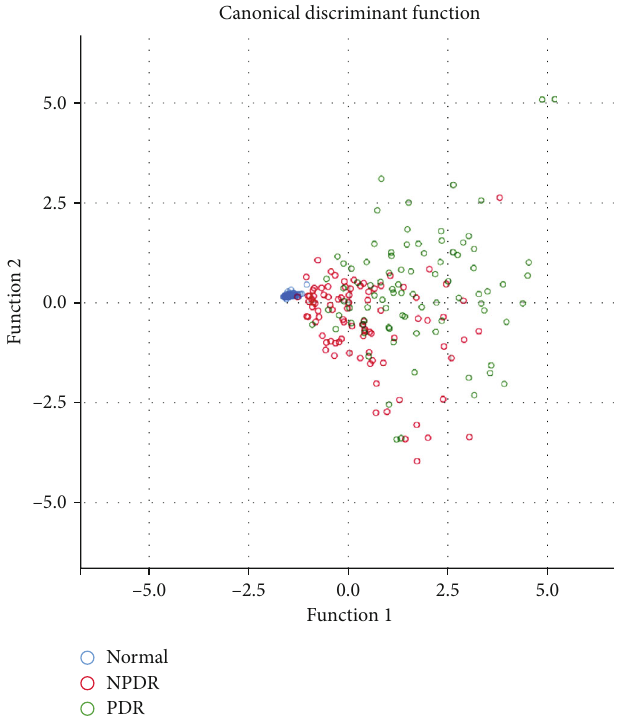
Figure 6: Canonical discriminant function. In the regression analysis, the arguments were ischemic area and leakage area, and the response variables were categories, i.e., normal, NPDR, and PDR. It demonstrates that there is a signi fi cant relationship between the biomarkers and the severity of